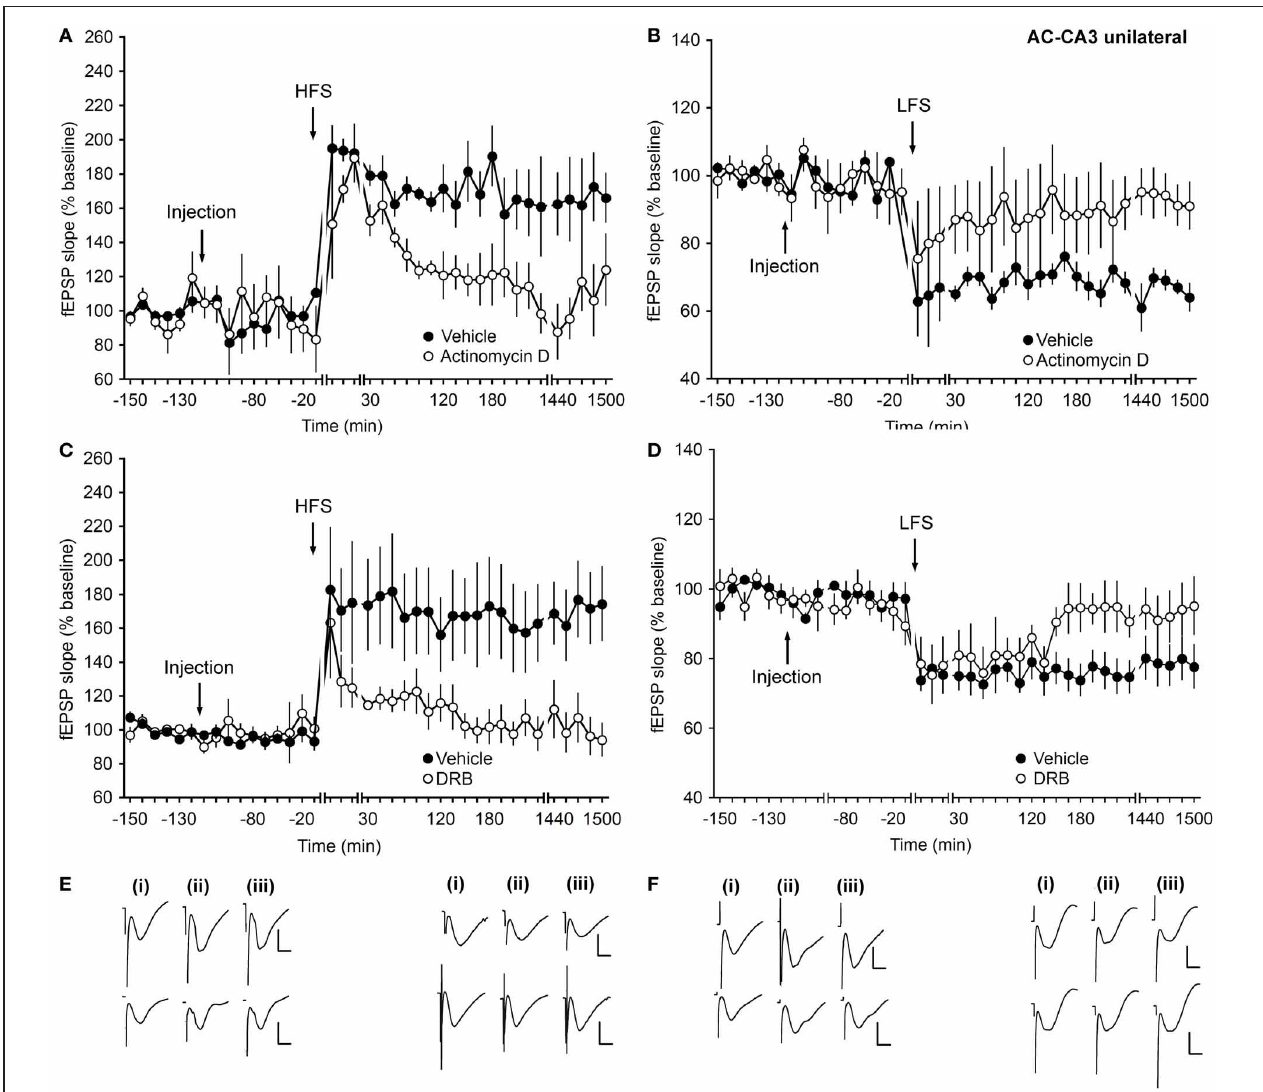
FIGURE 5 | Transcription inhibitors block early and late LTP, and late-LTD only, at associational/commissural–CA3 synapses. (A) In control experiments, application of HFS results in LTP ( > 24h). Injection of actinomycin D inhibits the early and late phase of LTP. (B) Application of LFS results in the expression of LTD ( > 24h). In the presence of actinomycin D, early and late phases of LTD are inhibited. (C) Injection of DRB inhibits the early and late phase of LTP compared to controls. (D) In the presence of DRB, early and late phases of LTD are inhibited compared to controls. Line breaks indicate change in time-scale. (E) Traces in the left panel represent fEPSP responses recorded pre-HFS (i) , 5min post-HFS (ii) , and 24h after HFS (iii) in the presence of vehicle (upper traces) or actinomycin D (lower